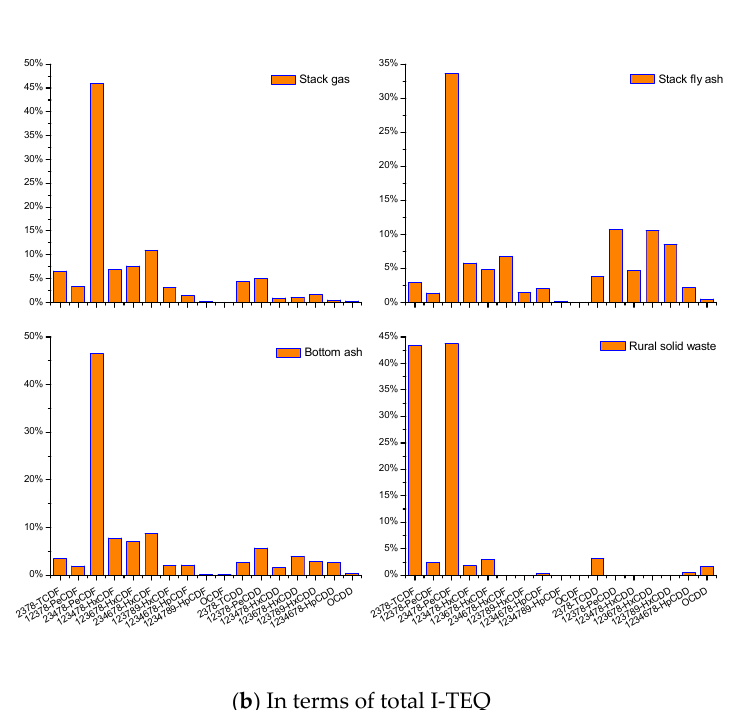
Figure 4. PCDD/F congener profiles in stack gas, fly ash, bottom ash, and RSW in terms of total concentration ( a ) and in terms of total I-TEQ ( b ).